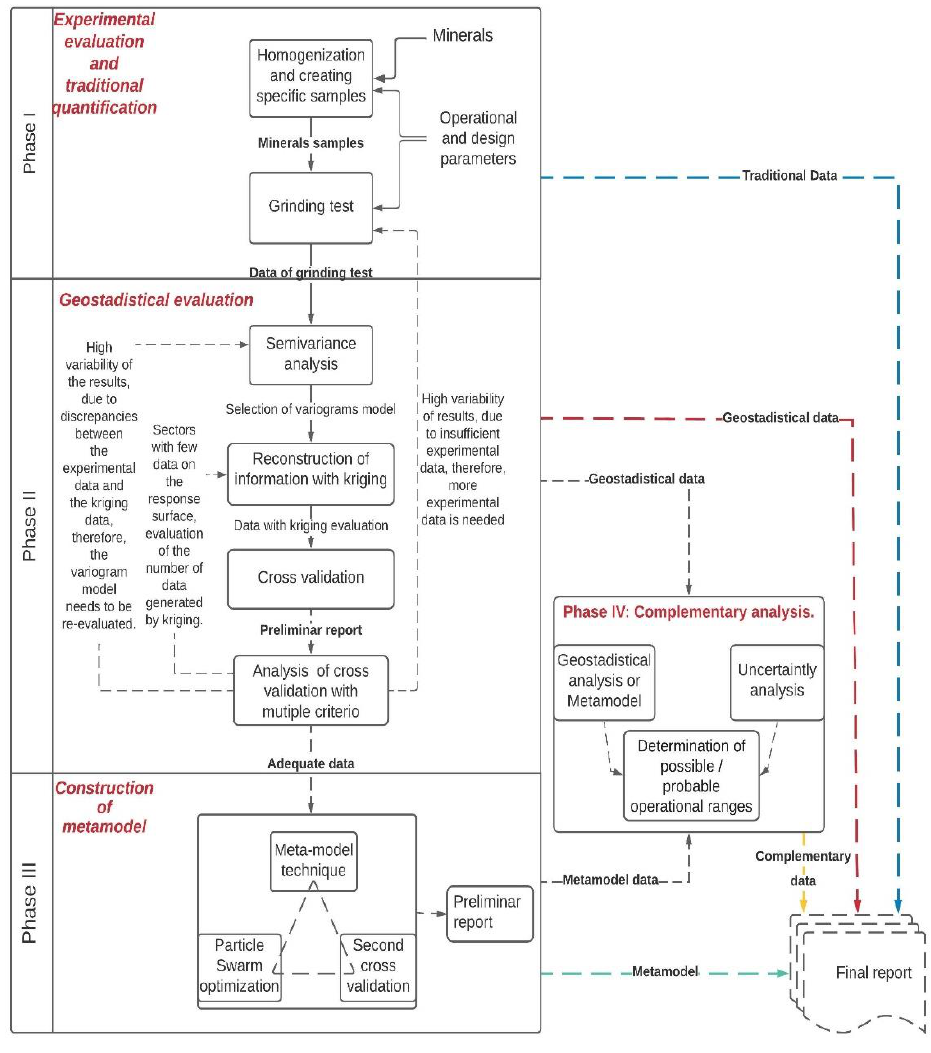
Figure 1. Illustration of the methodological proposal.